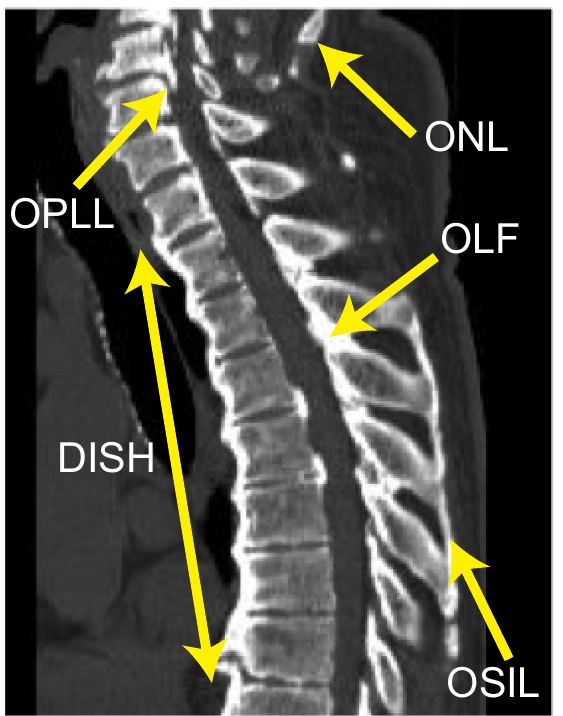
Figure 2. Representative sagittal computed tomography image for DISH, OPLL, OLF, OSIL and ONL. DISH, diffuse idiopathic skeletal hyperostosis; OLF, ossification of the ligamentum flavum; ONL, ossification of the nuchal ligament; OPLL, ossification of the posterior longitudinal ligament; and OSIL, ossification of the supra/interspinous ligaments.